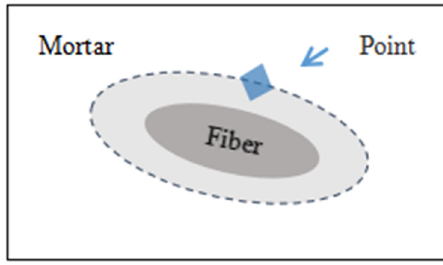
Table 6: The compressive and fl exural strengths of